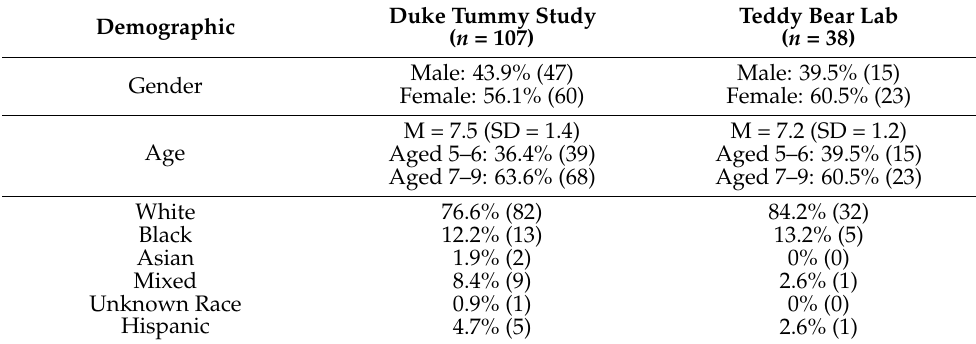
Table 2. Demographic information of study sample relative to the full sample.